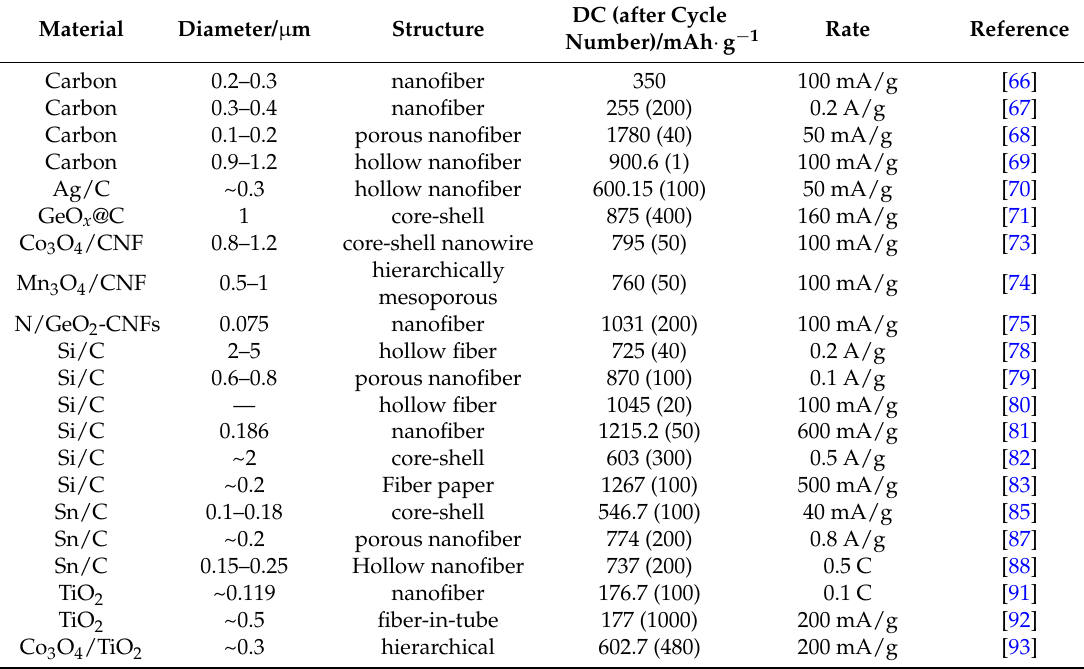
Table 2. Electrospun anode materials for LIBs and the corresponding electrochemical performance.